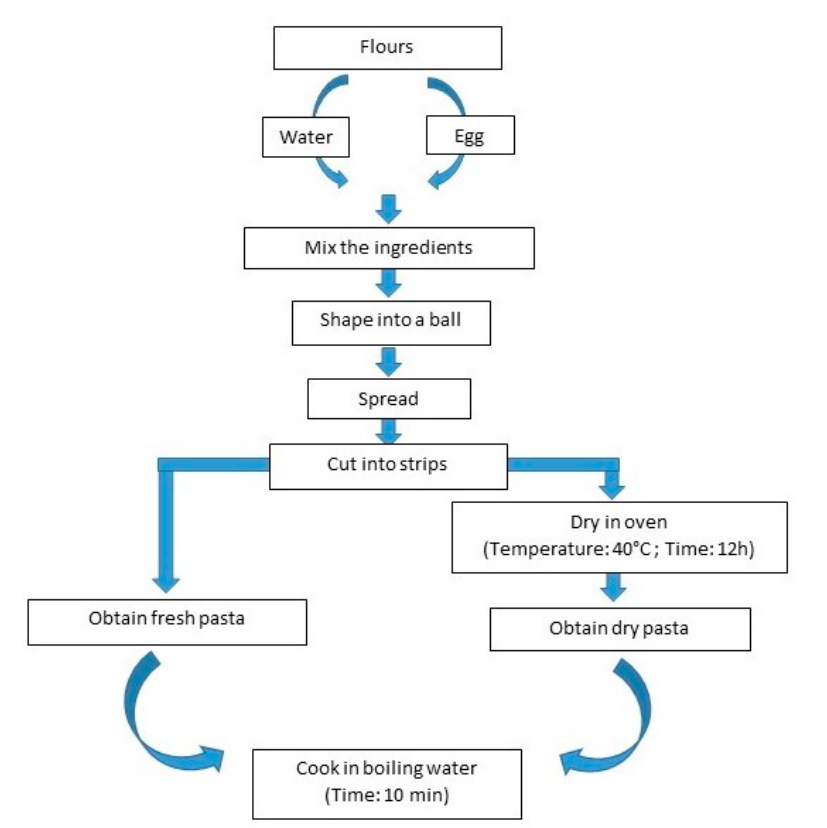
Figure 2. Preliminary pasta samples: fresh and dried.